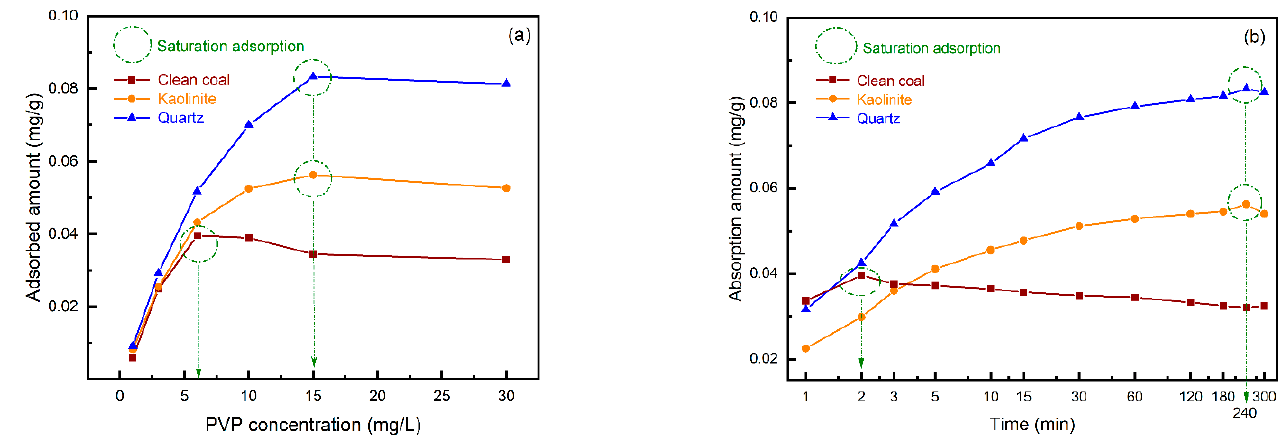
Figure 6. Adsorption amount of PVP on clean coal (wine), kaolinite (orange), and quartz (blue): ( a ) adsorption amount with an increase in the PVP concentration amd ( b ) adsorption amount with an increase in time.